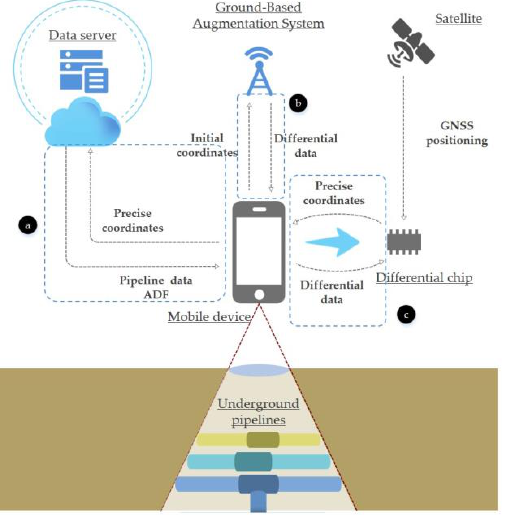
Figure 2. The procedures of pipeline loading: ( a ) obtaining differential corrections, ( b ) providing differential corrections solutions, and ( c ) loading data.